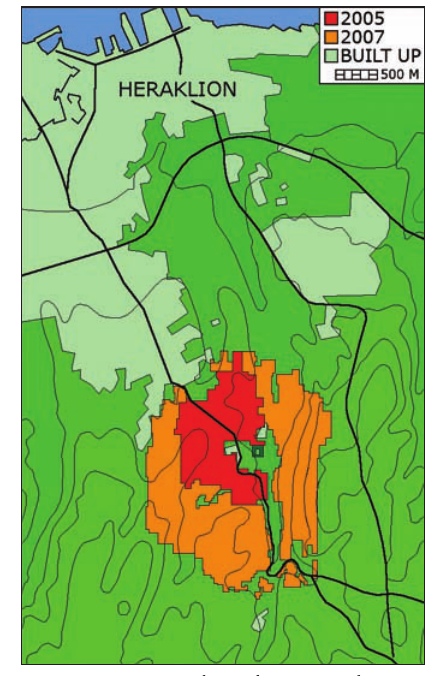
Figure 2 Knossos, the study area in relation to modern Heraklion.